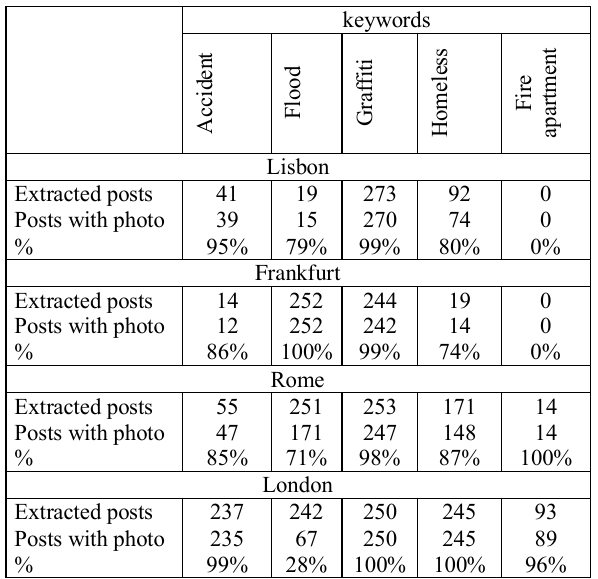
Table 2. Total number of posts, as well as number and percentage of posts with photographs per keyword for all considered cities